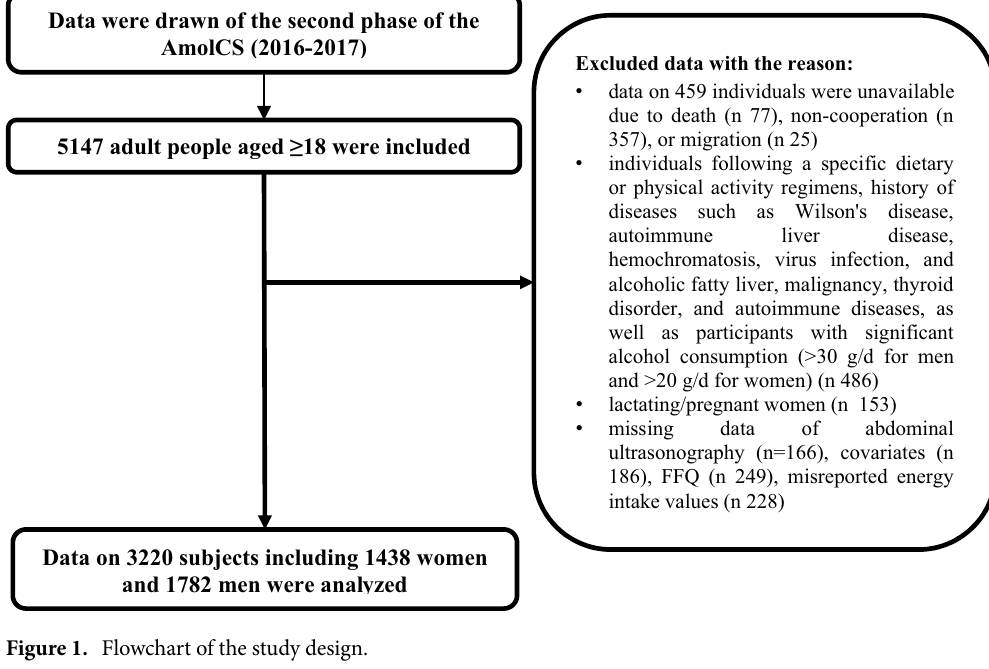
Figure 1. Flowchart of the study